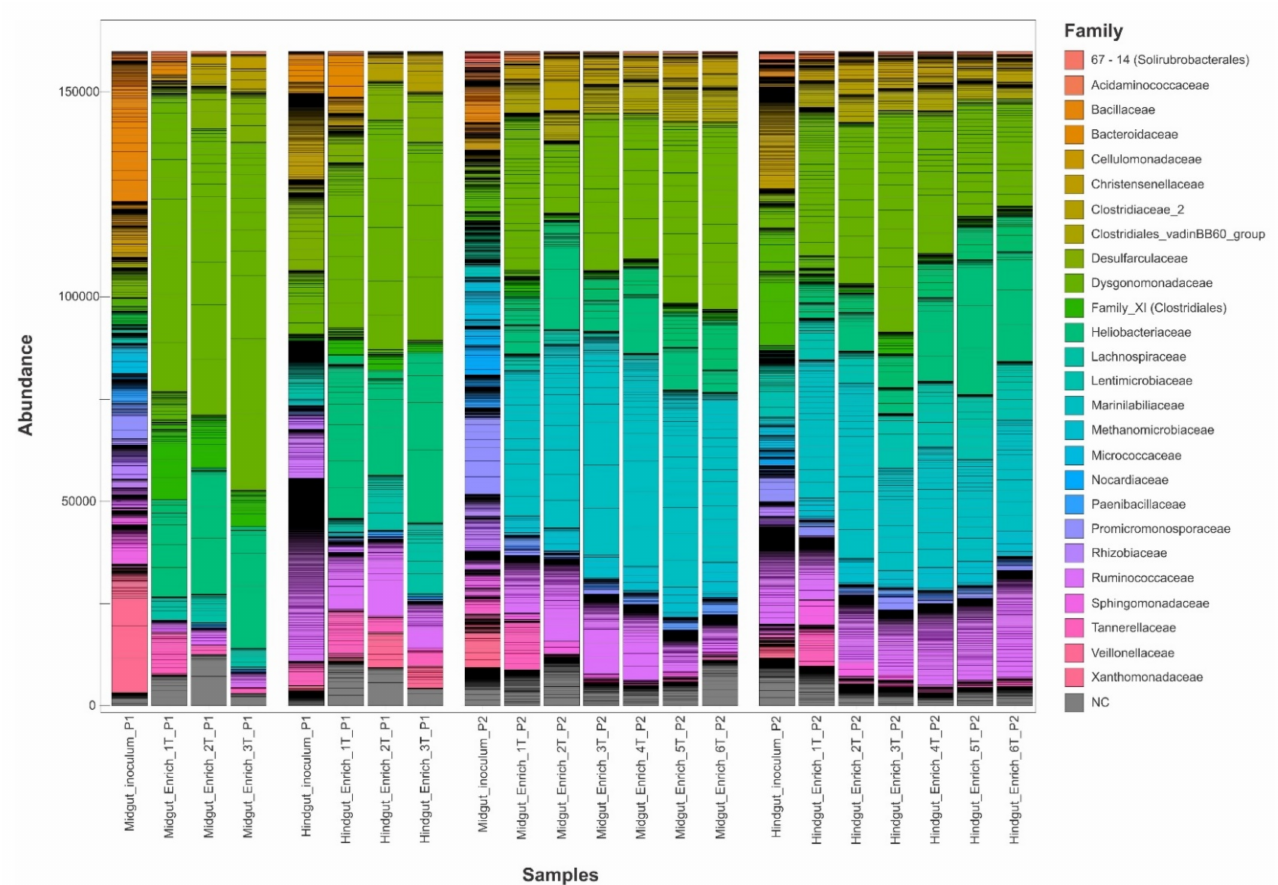
Figure 3. Bacterial community composition at the family level, analyzed by 16S rRNA gene amplicon sequences ( n = 3) on day 30 of cultivation in the midgut and hindgut enrichment cultures, with three transfers in P1, six transfers for P2, and inocula from midgut and hindgut for both inoculum preparation methods. Individual genera within a color-defined family are separated by horizontal lines. The number of sequence reads was rarefied for better comparison. NC = not classified at the family